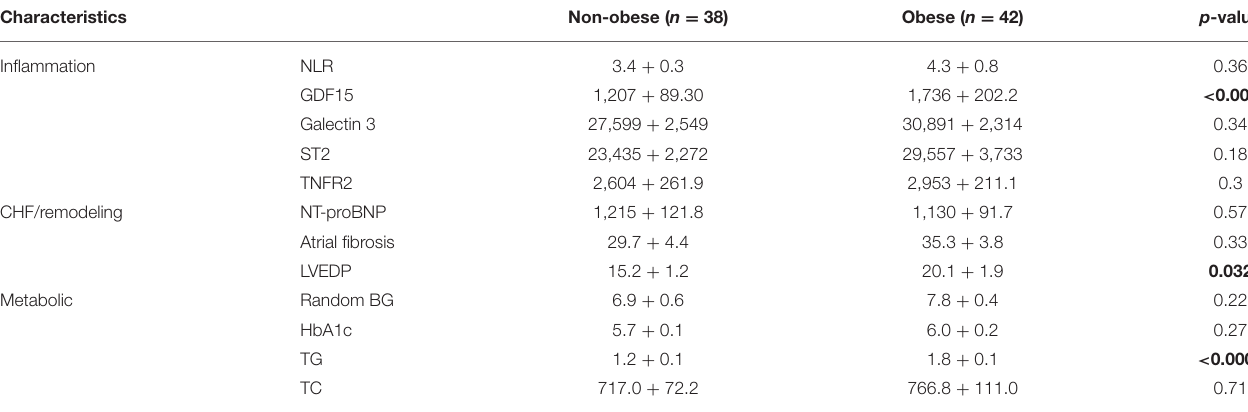
TABLE 3 | Biomarker findings. Characteristics